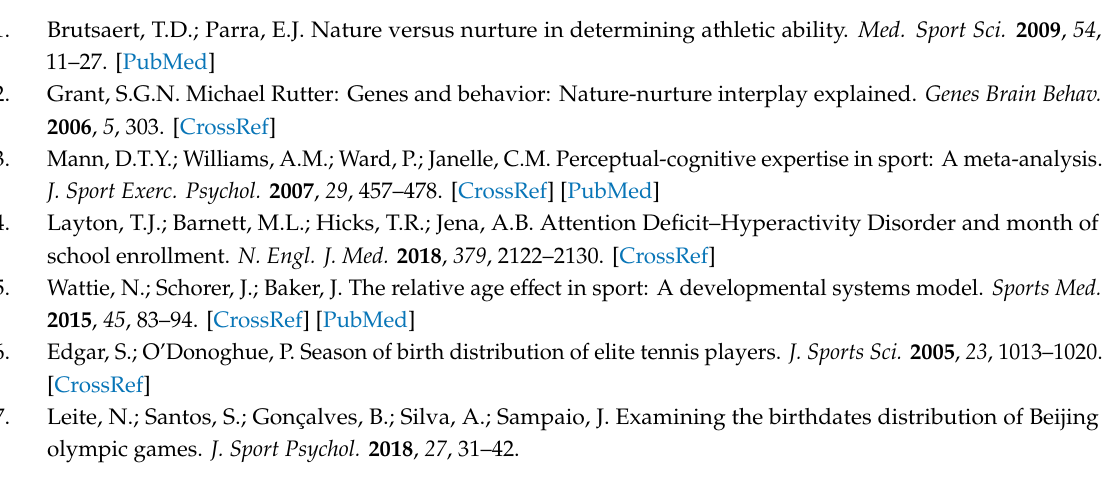
Table S1: Correlations between Age, Anthropometrics, Physical Fitness and Attentional Functions per age group. Author Contributions: Conceptualization and methodology, F.H., R.B. and J.L.; software, formal analysis